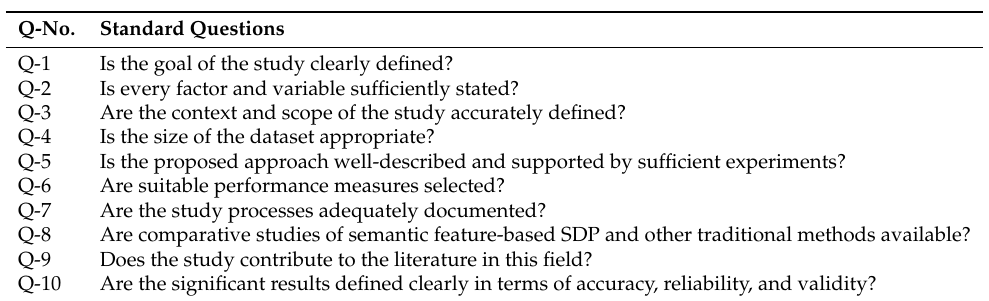
Table 2. Quality assessment